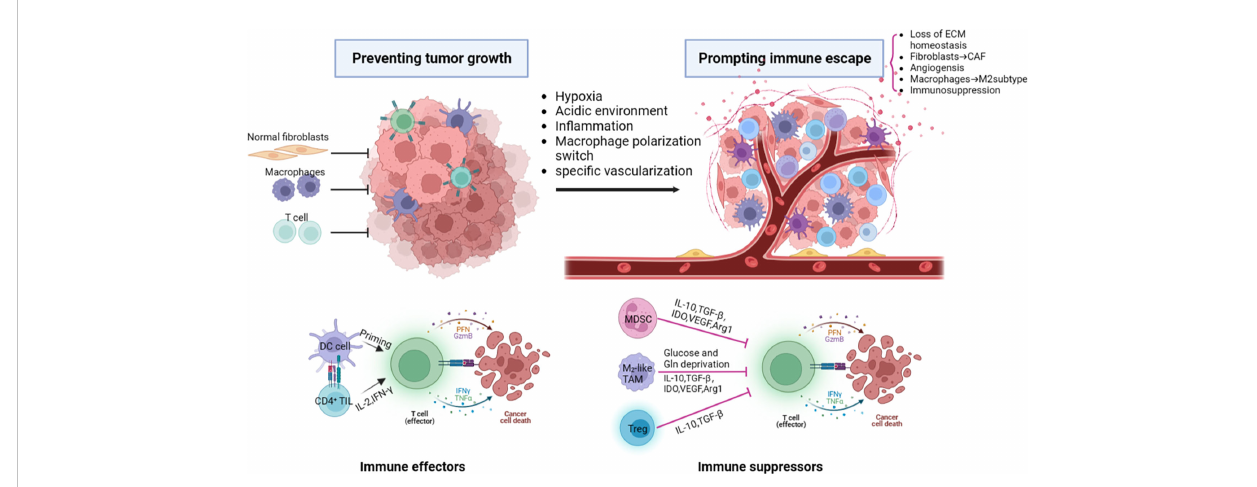
FIGURE 1 The major components and characteristics related to tumor progression within the tumor microenvironment. ECM, extracellular matrix; CAF, cancer-associated fi broblast; DC, dendritic cells; PFN, perforin; GzmB, granzyme B; IFN g , interferon g ; TNF a , tumor necrosis factor a ; TGF- b , transforming growth factor- b ;MDSC, myeloid-derived suppressor cell; IDO, Indoleamine 2,3-dioxygenase; VEGF, vascular endothelial growth factor; Arg1, arginase 1; Gln, glutamine; Treg, regulatory T